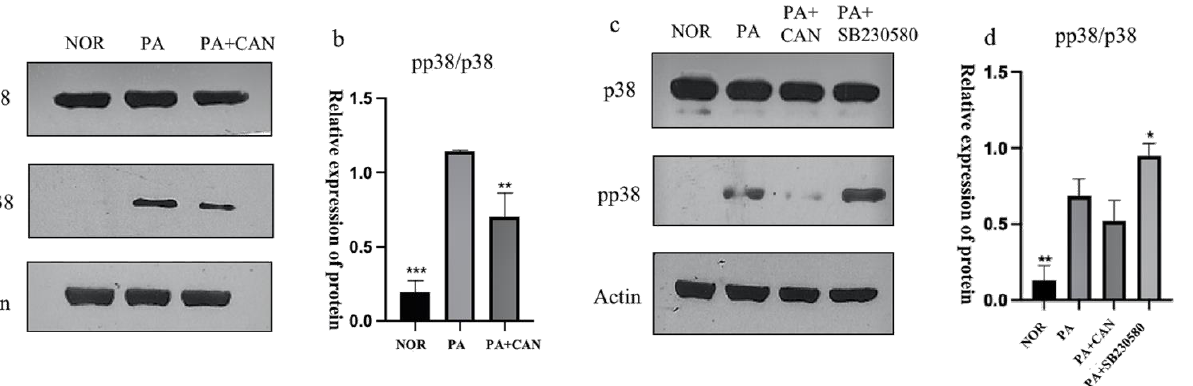
Figure 6. CAN inhibited p38 protein activation. ( a , b ) CAN (5 µg/mL) reduced the phosphorylation level of p38 protein. ( c , d ) The effect of the p38 inhibitor SB230580 (10 µM) on p38. Data are expressed as the means ± SD ( n = 3); * p < 0.05, ** p < 0.01, *** p < 0.001 vs. PA.